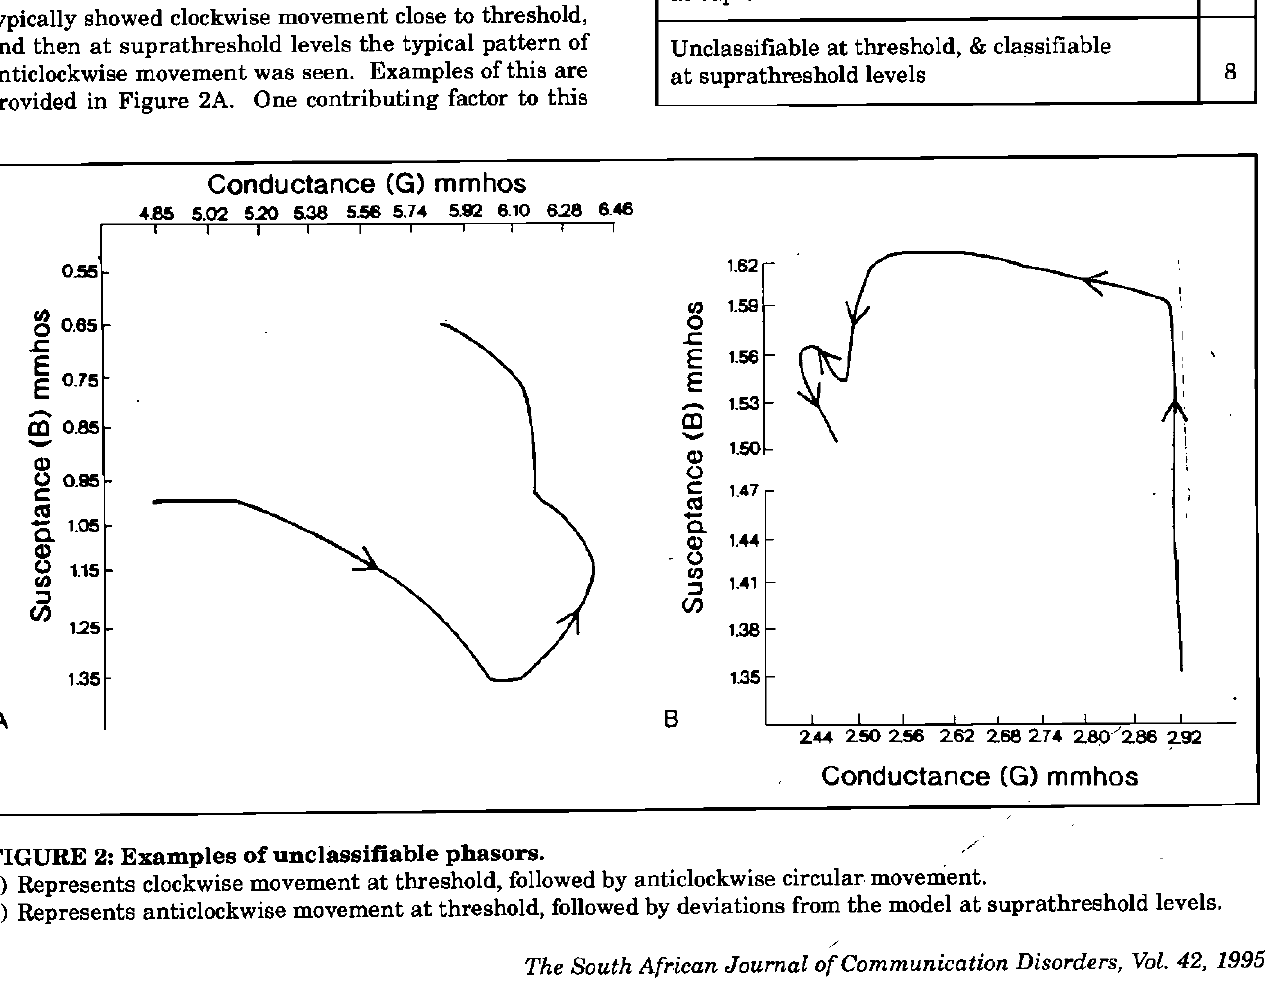
FIGURE 2: Examples of unclassifiable phasors. a) Represents clockwise movement at threshold, followed by anticlockwise circular movement. b) Represents anticlockwise movement at threshold, followed by deviations from the model at suprathreshold